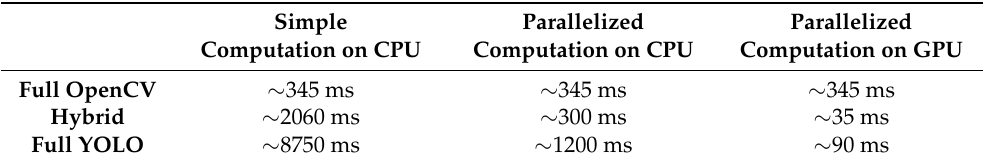
Table 2. Average time in milliseconds to perform detection on an image according to the different hardware configurations and the three pipeline variations. Simple Parallelized Parallelized Computation on CPU Computation on CPU Computation on GPU Full